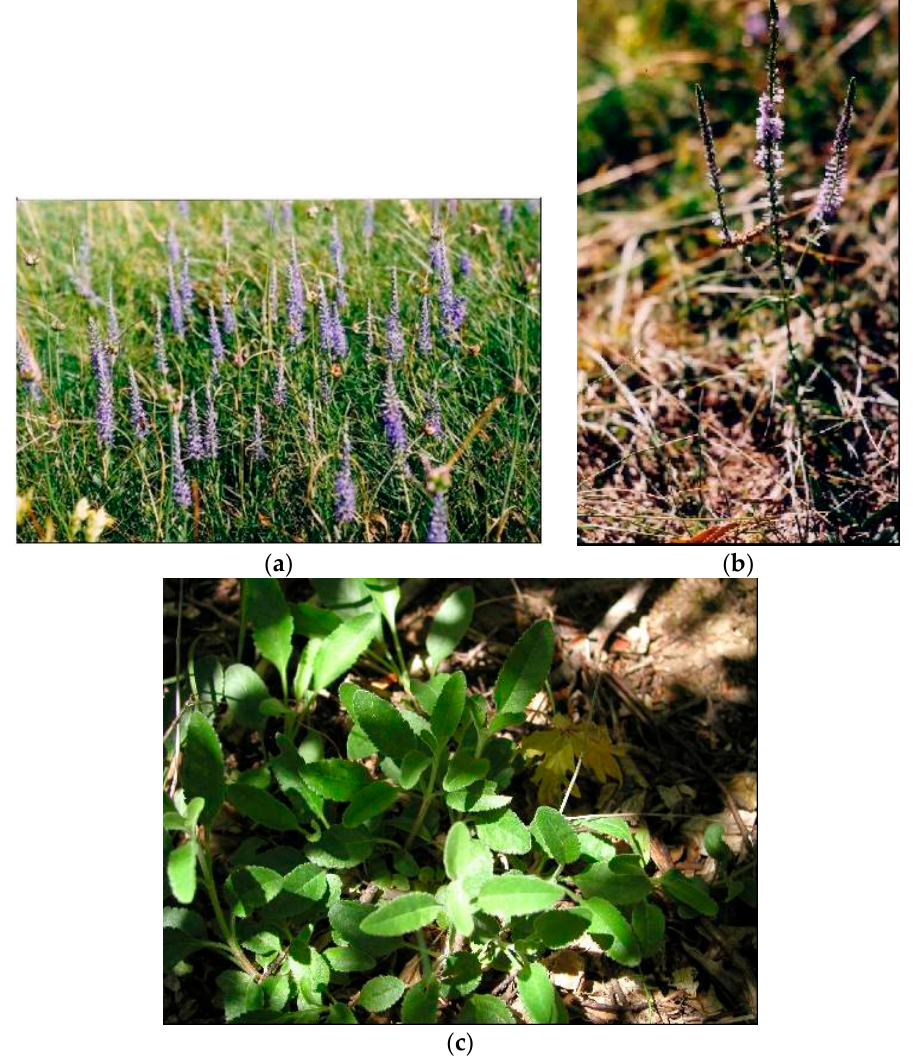
Figure 4. S. recta L. subsp. recta ( a ) plant in flowering stage; ( b ) detail of the flower; ( c ) detail of leaf.